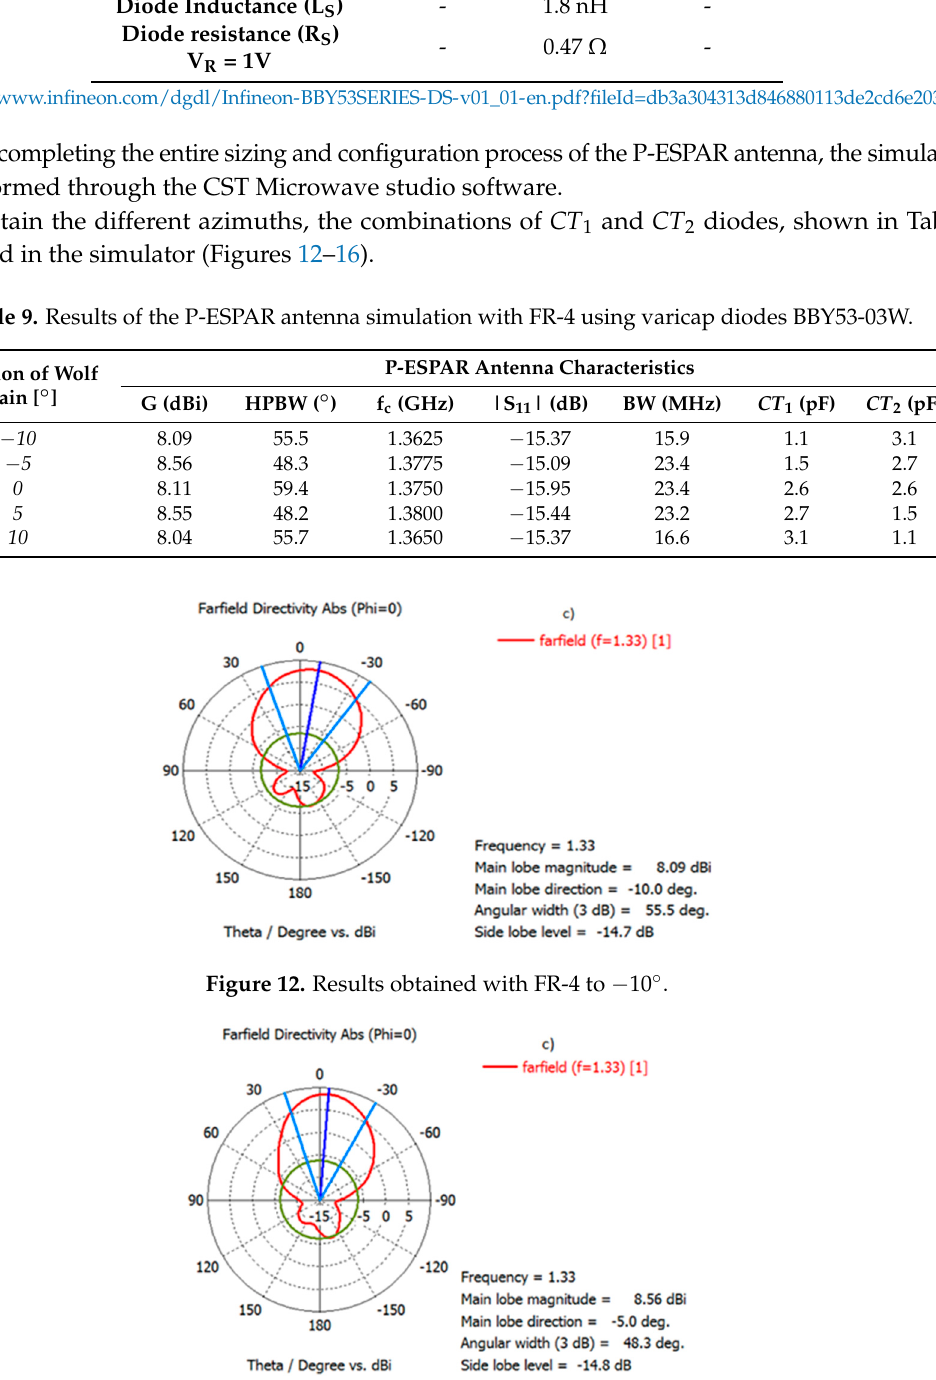
Table 8. Characteristics of varicap diodes.